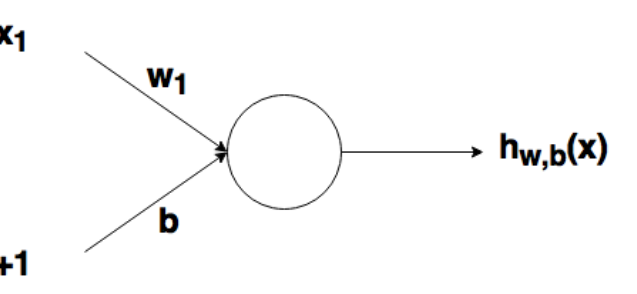
Figure 10. A node with displacement at the input.